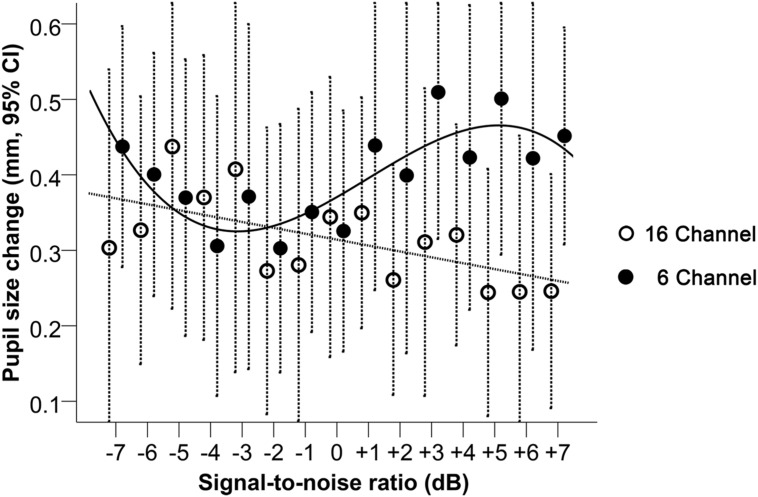
Pupil size change relative to baseline during 16-and 6-channel vocoded sentence recognition at SNRs between -7 and +7 dB. Dashed bars indicate 95% CI. The trend lines shown correspond to the best model fit, respectively, for the 16- and the 6-channel conditions.